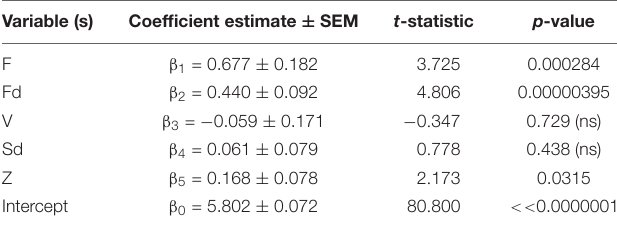
TABLE 1 | Multiple regression model of interest rating (I) as a function of all eye tracking predictor variables I = β 0 + β 1 *F + β 2 *Fd + β 3 *V + β 4 *Sd + β 5 *F*Fd +